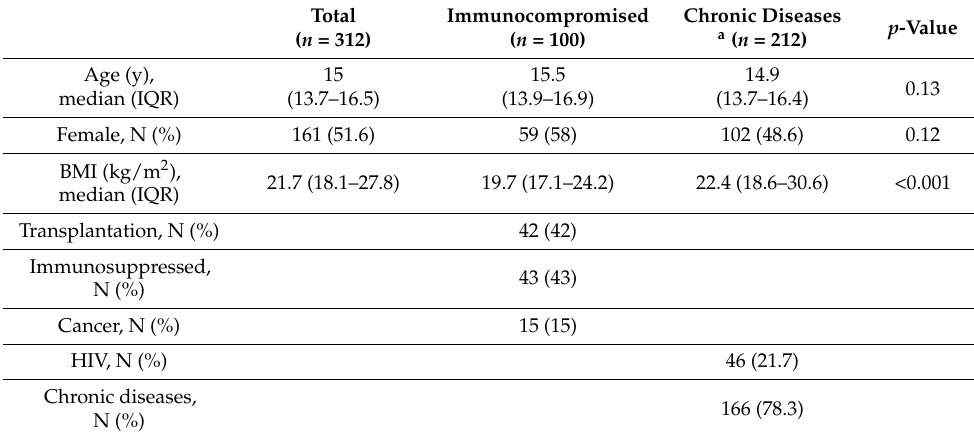
Table 1. Baseline characteristics of the study